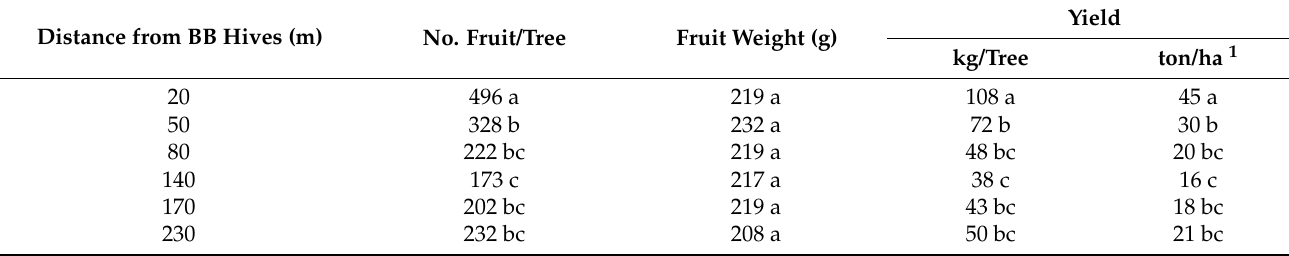
Table 3. Effect of adding bumblebee (BB) hives (April 2018) on the number of fruit per tree, fruit weight, and total yield (February 2019) at six distances from the BB hives, Kfar Hanassi, 2018/19. Distance from BB Hives